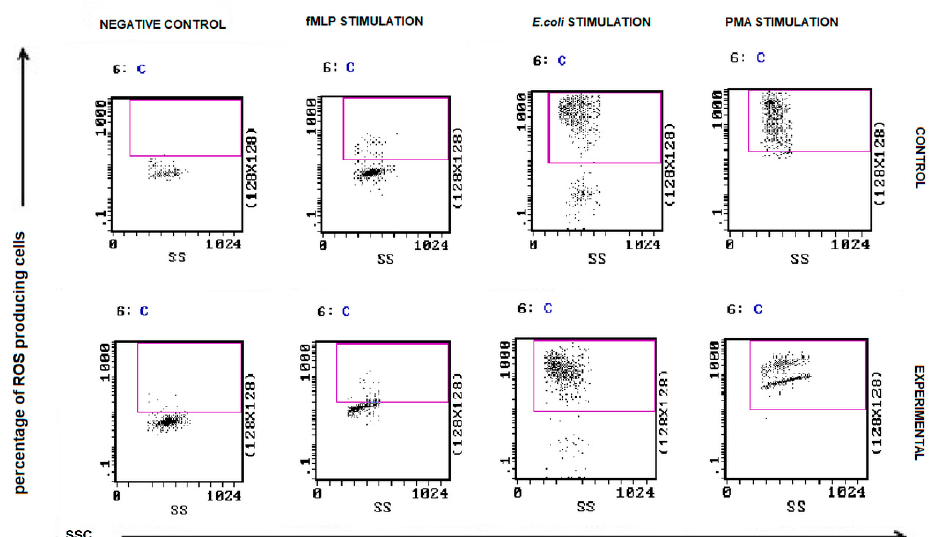
Figure 7. Flow cytometric results showing the mean values of the percentages and MFI of phagocytic cells (monocytes and granulocytes) after exposure to fluorescent labeled E. coli in the peripheral blood of female dogs with malignant tumors of diverse origin and the control group. Mean values of phagocyte percentages (±SD) in female dogs with tumors of epi- thelial origin (E); female dogs with tumors of mesenchymal origin (M); and the control group (C). Statistically significant differences at p < 0.05 (*); at p < 0.01 (**).